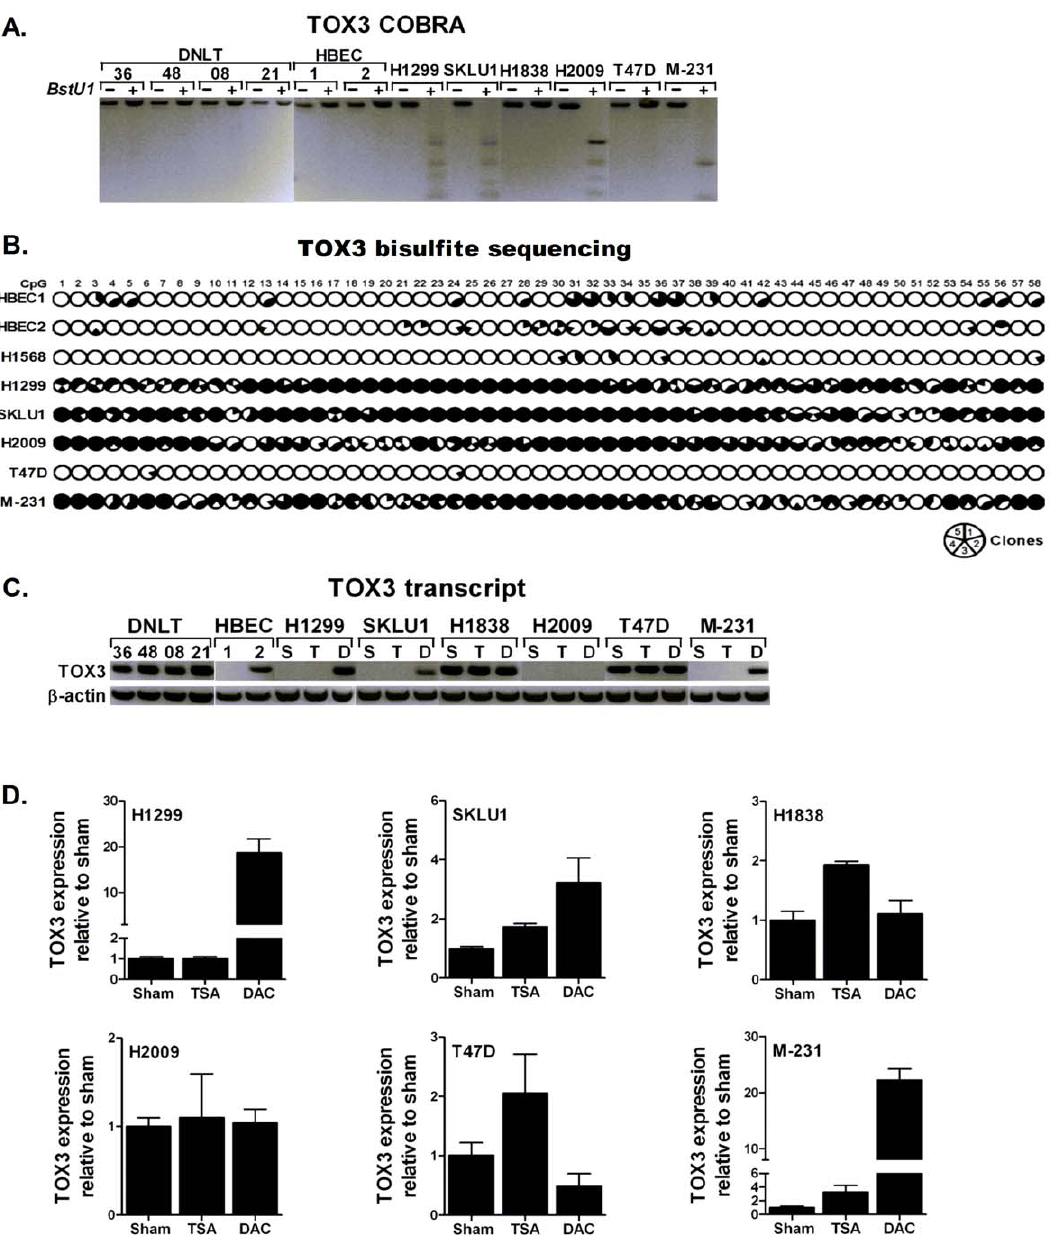
Figure 4. Methylation and expression of TOX3 in lung and breast cancer. ( A ) COBRA and ( B ) bisulfite sequencing assays were used to assess the methylation status of TOX3 and the results are summarized as described for figure 1. ( C ) Expression of TOX3 and beta-actin in DNLT, HBEC, and various lung and breast cancer cell lines. TOX3 was silenced in vehicle-treated (S) lung cancer (H1199, SKLU1, and H2009) and breast cancer (MDA-MB- 231, abbreviated as M-231) cell lines with methylated promoter CpG island. Treatment with 5-Aza-2 9 -deoxycytidne (D) but not trichostatin A (T) restored TOX3 expression. ( D ) Quantitative analysis of TOX3 in lung and breast cancer cell lines treated with Vehicle (Sham), TSA, and DAC using a TaqMan assay that uses primer sets distinct from the primers used for gel-based assays confirmed results shown in figure